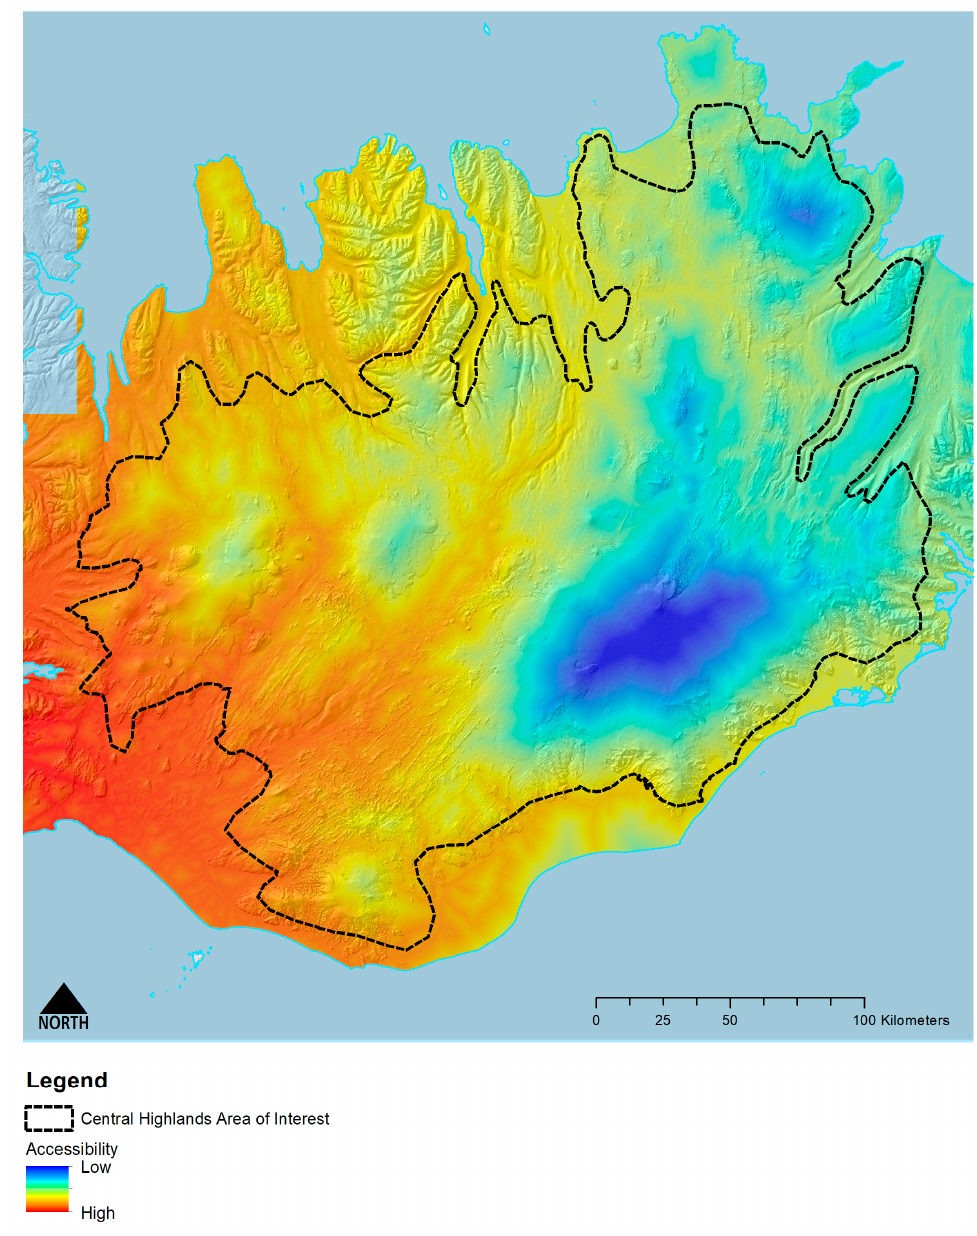
Figure 11. Obtained values for accessibility for the Central Highlands . Table 3. Wilderness character summary figures .